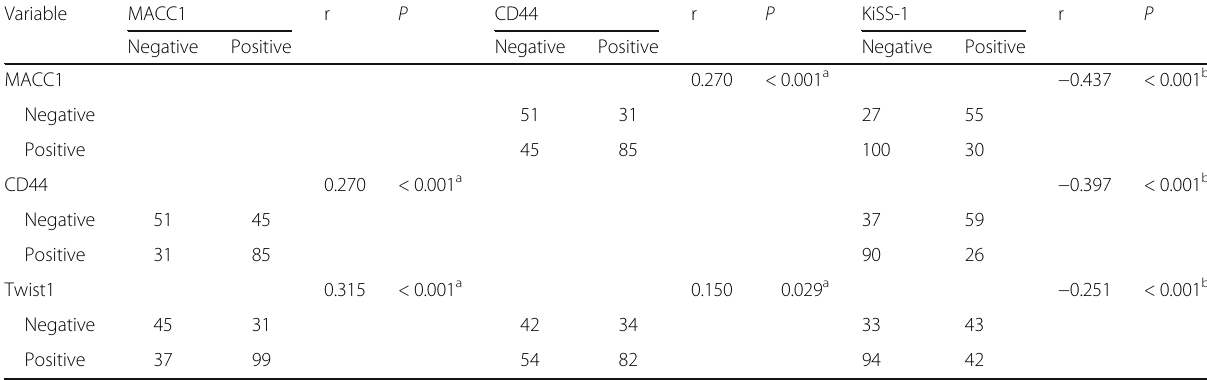
Table 3 Correlation among MACC1, CD44, Twist1 and KiSS-1 in CAC Variable